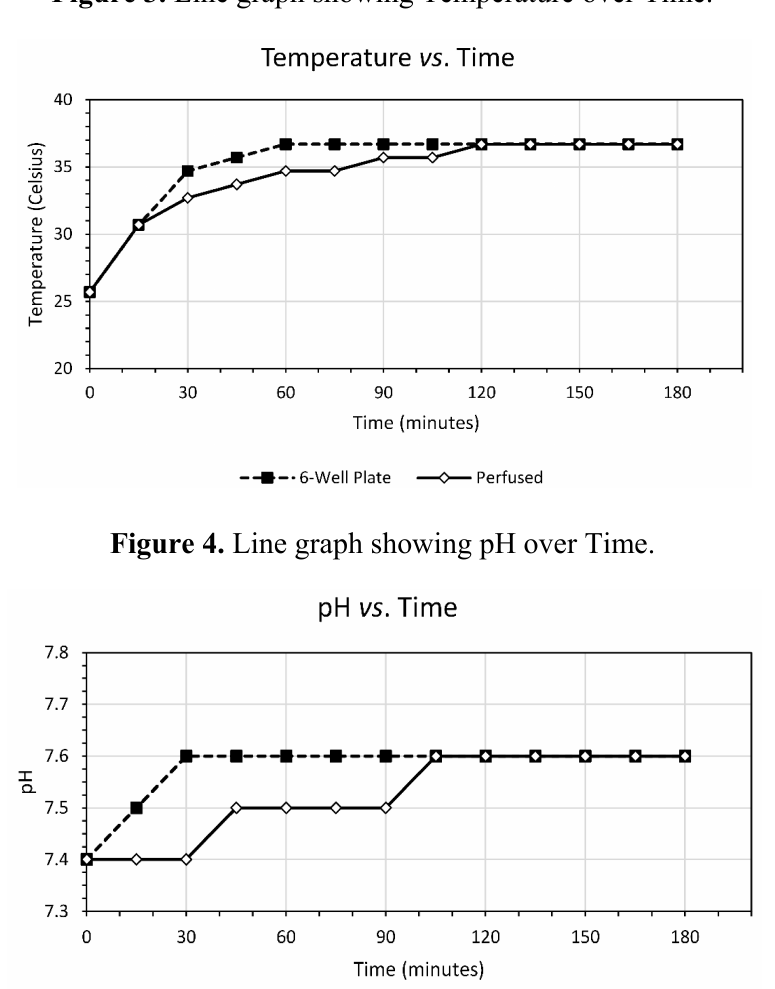
Figure 3. Line graph showing Temperature over Time.